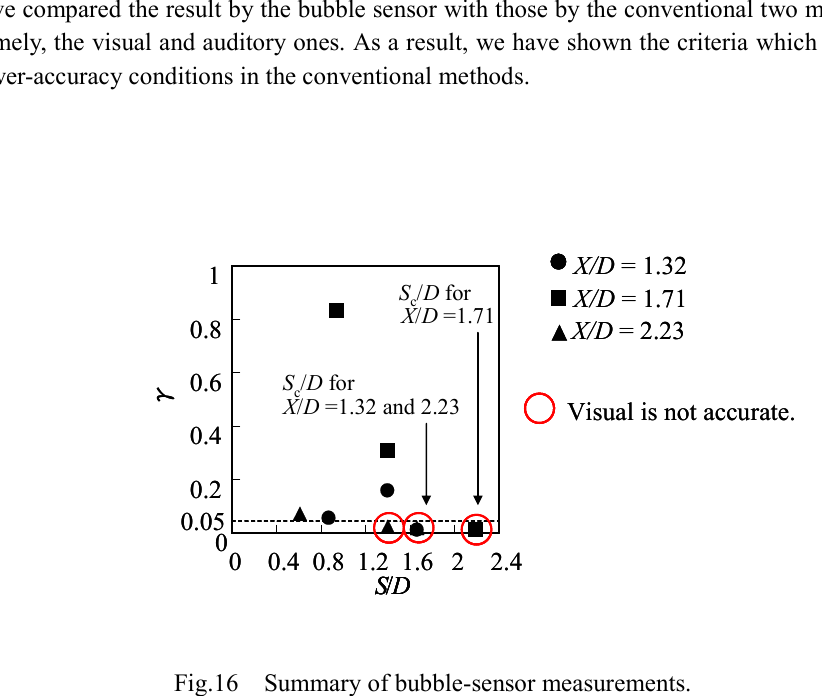
Fig.16 Summary of bubble-sensor